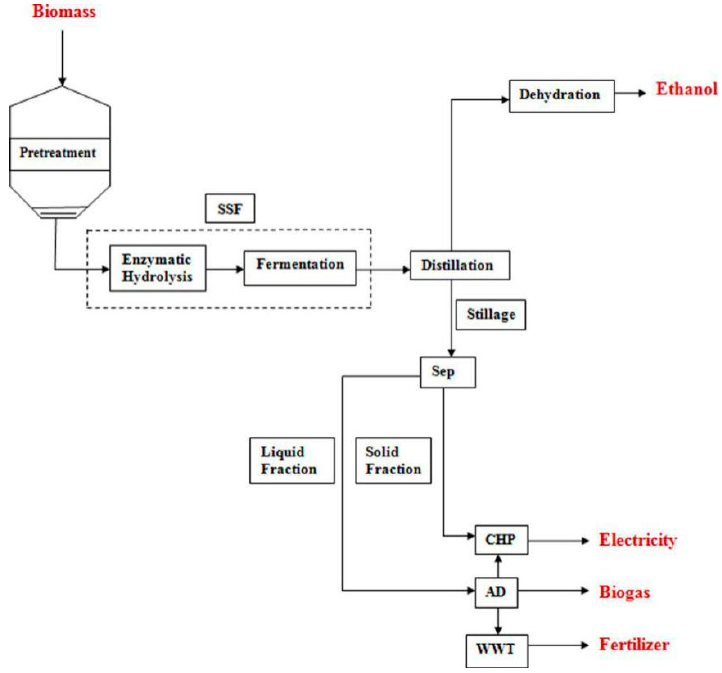
Figure 5. Flow diagram of the enzymatic ethanol production process [21].